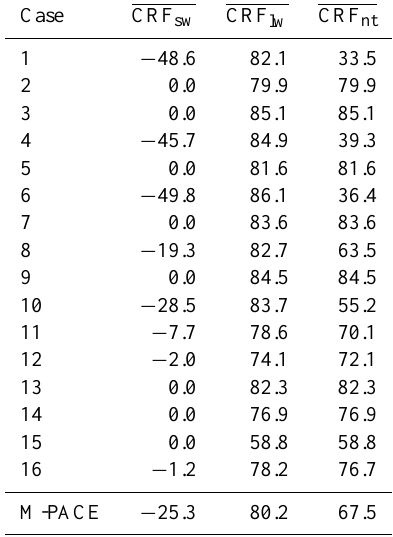
clouds by case, and for the entire period. The M-PACE mean short-